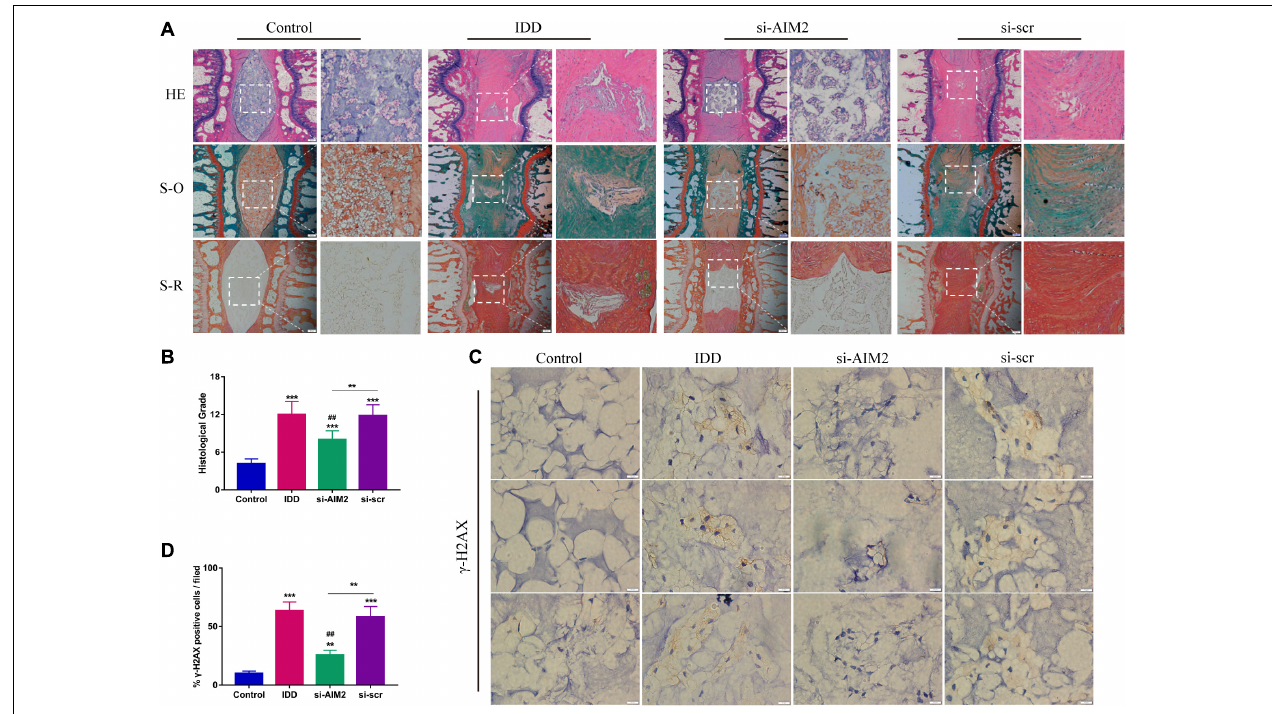
FIGURE 7 | Inhibition of AIM2 retards IDD progression in vivo . (A) Histological staining, including hematoxylin-eosin (HE), safranin O (S-O), and Sirius red (S-R) staining, showed the morphology of rat disc tissues. The IDD, si-AIM2, and si-scr group were conducted with needle puncture. (B) Histological grades to evaluate the degree of disc degeneration in different group. (C,D) Immunochemistry results of γ -H2AX in rat dis tissues (C) and quantification of c γ -H2AX-positive cell rate (D) . Data were presented as the means ± SD, n = 6. ** P < 0.01, *** P < 0.001 vs. control group; ## P < 0.01 vs. IDD